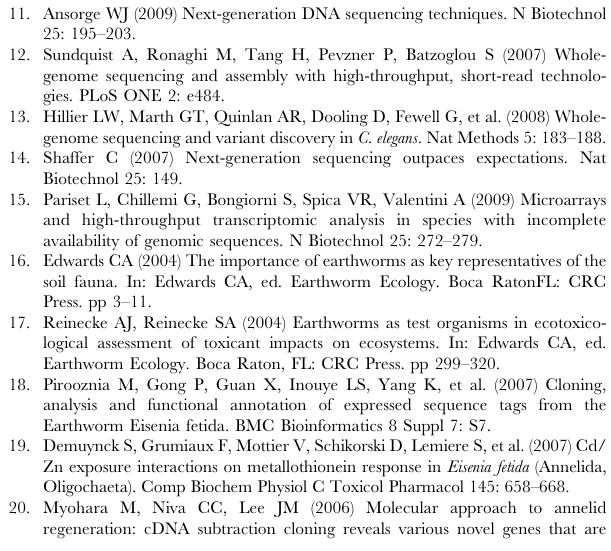
Figure S1 Taxonomic tree. Evolutionary distances among four earthworm species (Eisenia fetida, Eisenia andrei, Lumbricus rubellus, and Lumbricus terrestris), the marine polychaete bristle worm Capitella capitata and the nematode worm Caenorhabditis elegans.